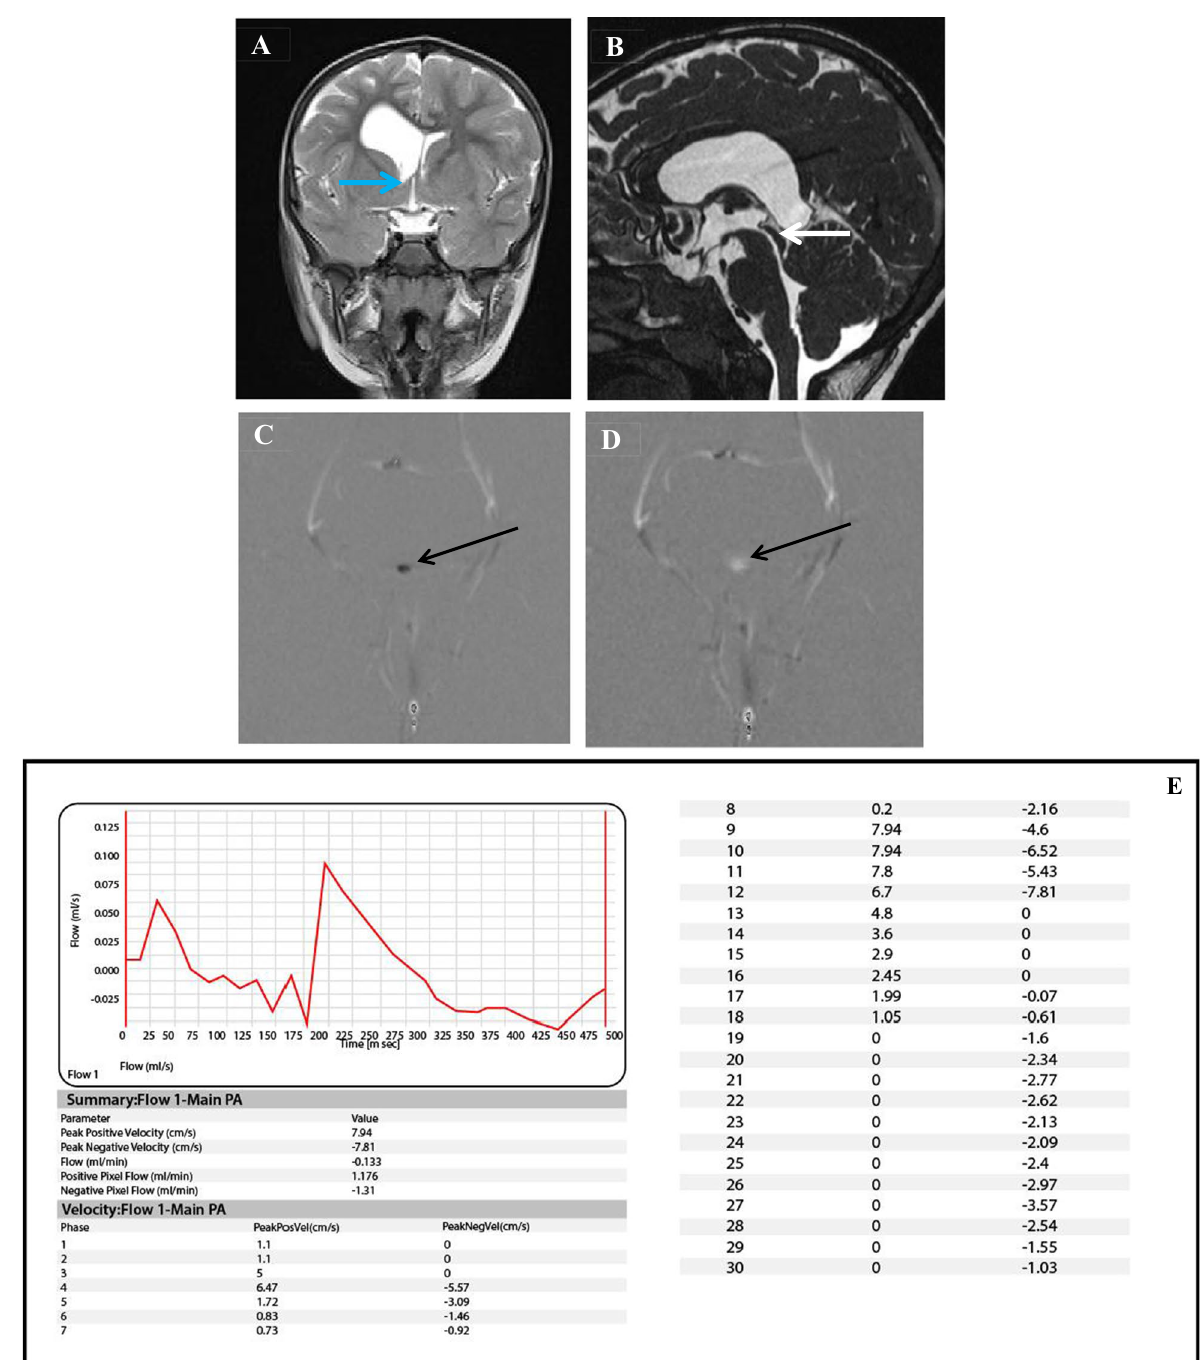
Fig. 3 A – E A 10‑year‑old male child with headache and blurring of vision. A Coronal T2W image shows asymmetry of both lateral ventricles being larger on the right side with obstructing membrane in the right foramen of Monro (blue arrow), B sagittal T2 DIVER image reveals patent normal aqueduct (white arrow), C , D axial phase‑contrast images reveal normal CSF flow through the aqueduct at systole ( C ) and diastole ( D ) (black arrows), and E velocity time curve‑ and CSF flow curve‑associated table reveals irregular CSF flow curve indicating irregular to and fro movement of the CSF proximal to the site of obstruction with PSV: 7.8 cm/s, PDV:7.9 cm/s, MV: 7.8 cm/s, MSF: 0.176 m/s and SV: 61 µl (hyperdynamic CSF circulation with high CSF velocities and stroke volume and normal flow through aqueduct of Sylvius unilateral obstructive hydrocephalus at level of foramen of Monro by a